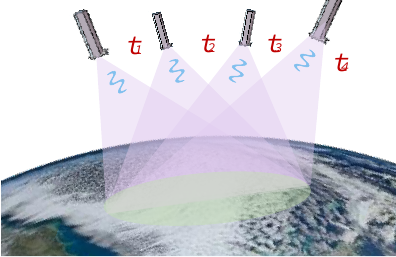
Figure 1. Diagram of the sparse aperture observation.